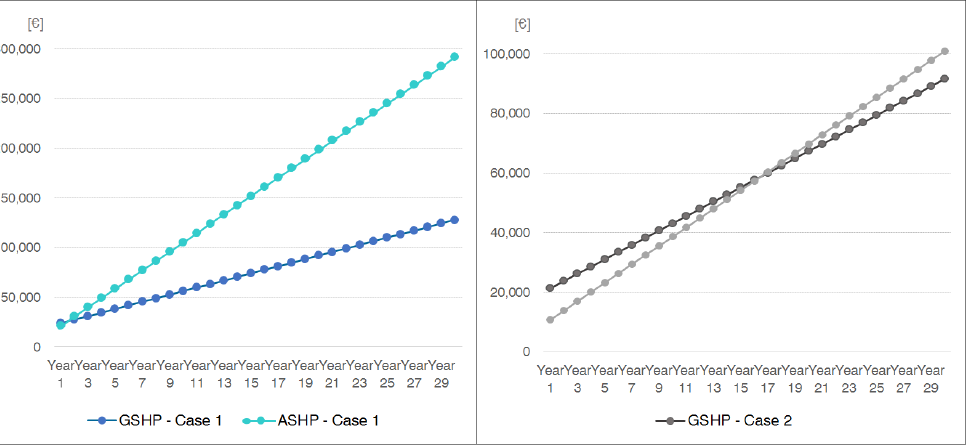
Figure 8. Economic comparison of the heating systems included here in both scenarios, case 1 ( left ) and case 2 ( right ).